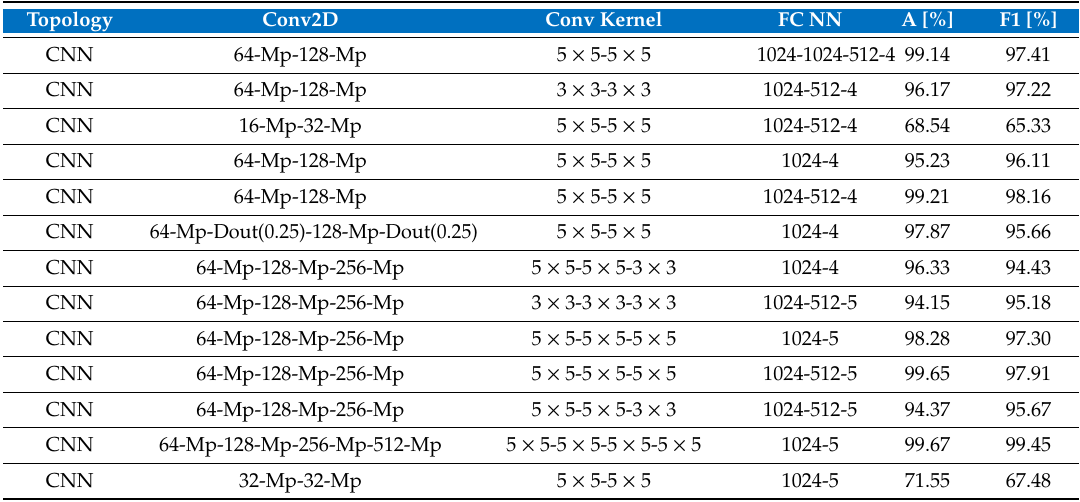
Table 1. Exemplary comparison of PD image multilabel classification performance of